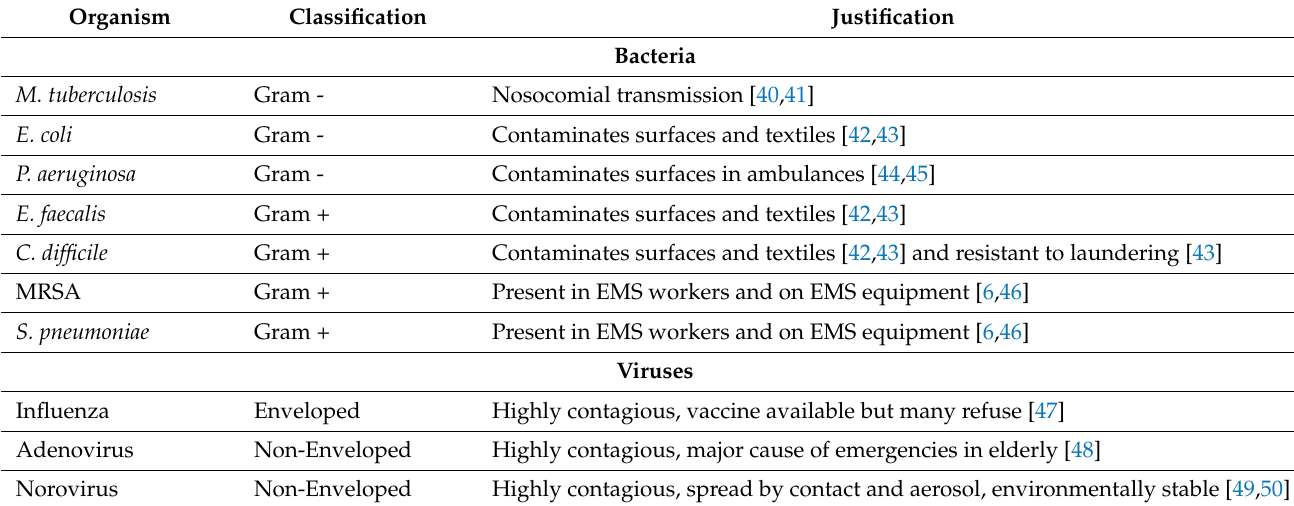
Table 1. Common healthcare-associated infectious agents and their justification as targets in this study.